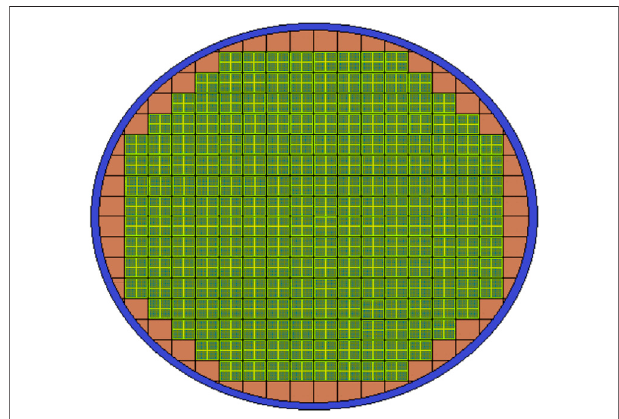
FIGURE 1 | The core design of the designed BWR system in MCNPX.